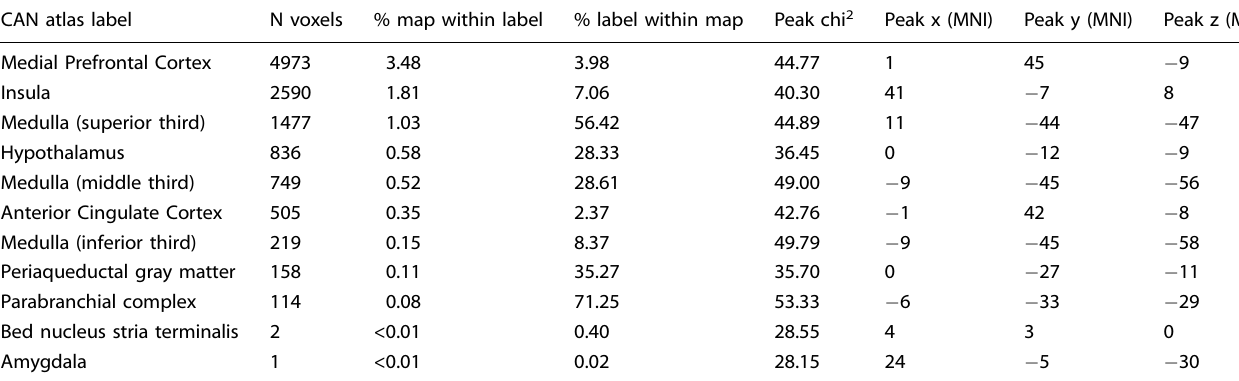
Table 3. Intersection between NNiqr -BOLD sync-difference map and CAN. CAN atlas label N voxels % map within label % label within